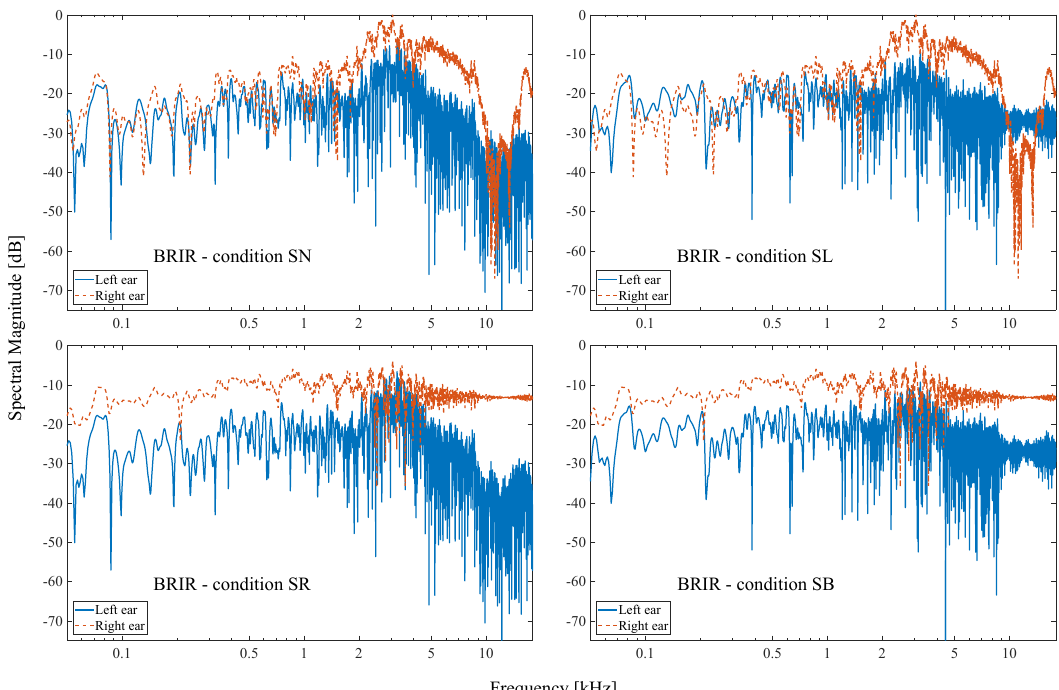
Figure 4. Examples of magnitude spectra for the BRIR at 60° for the “SN” (left top), “SL” (right top), “SR” (left bottom), and “SB” (right bottom) conditions. The solid and dashed curves denote the magnitude spectra for the BRIR of left and right ears,